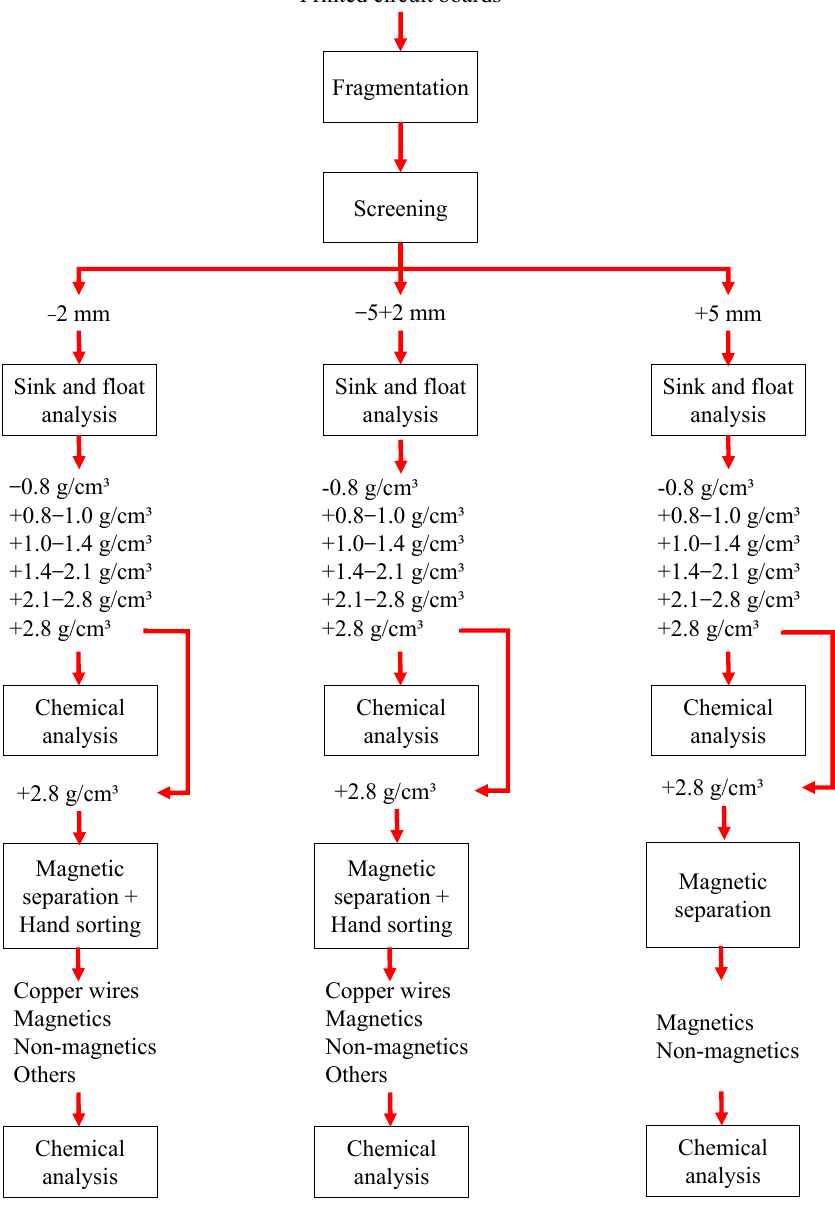
Figure 2. Scheme adopted for wasted PCB characterization. The composition analysis of the +2.8 g/cm 3 fraction is described in more detail in Section